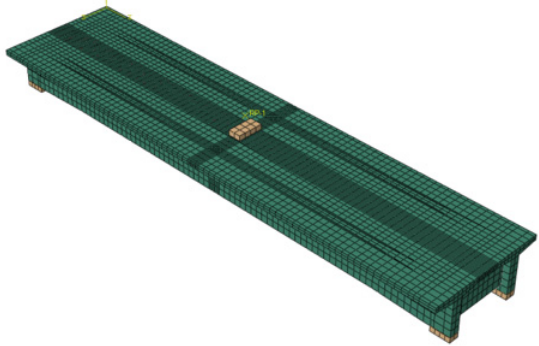
Figure 13. The mesh element in the geometric model of the bridge slab.